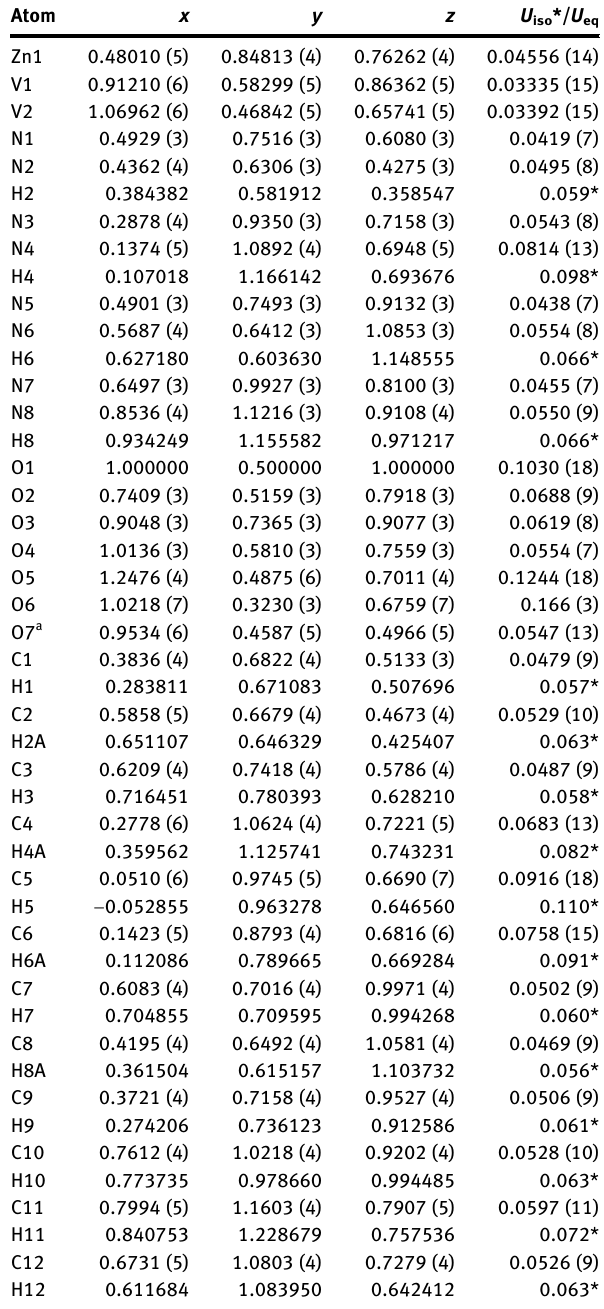
Table  : Fractional atomic coordinates and isotropic or equivalent isotropic displacement parameters (Å 